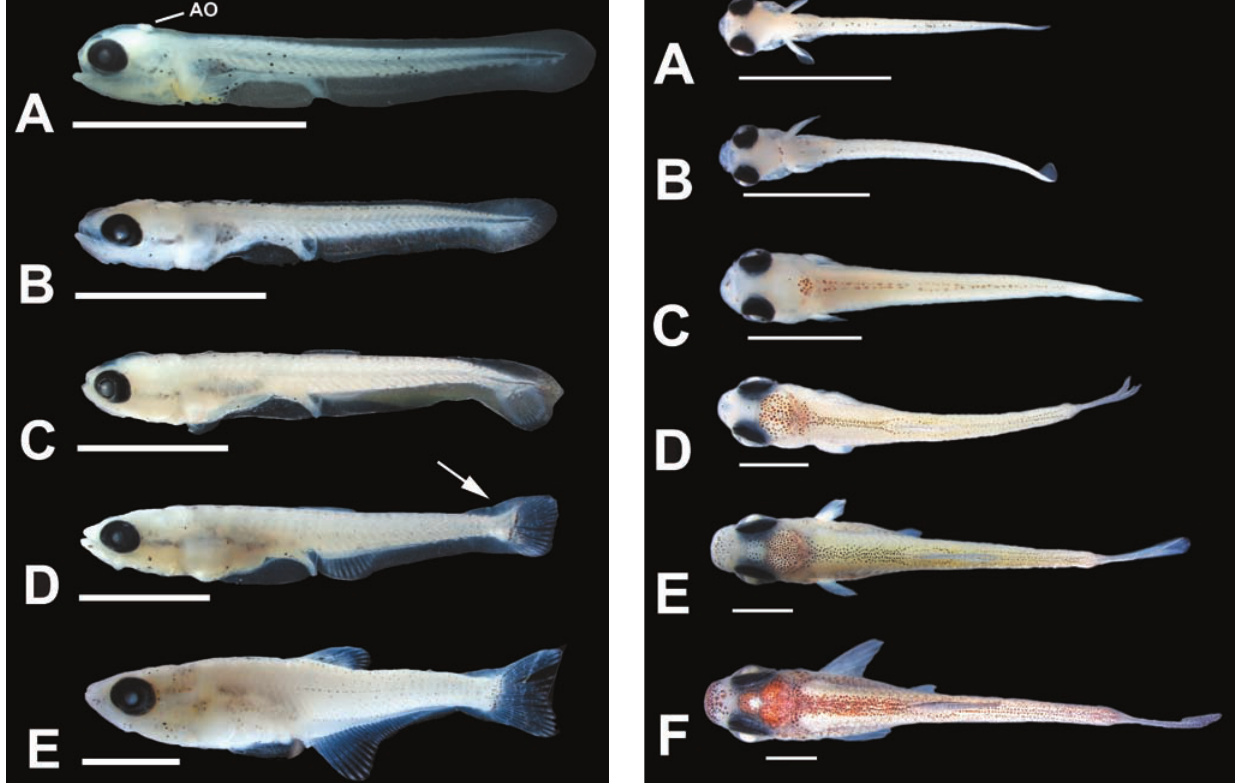
Fig. 4. Larvae and juveniles of Heterocharax macrolepis , dorsal view. A: 3.9 mm NL; B: 5.1 mm NL; C: 7.3 mm SL; D: 10.2 mm SL; E: 13.6 mm SL; F: 16.2 mm SL. Scale bar: 2